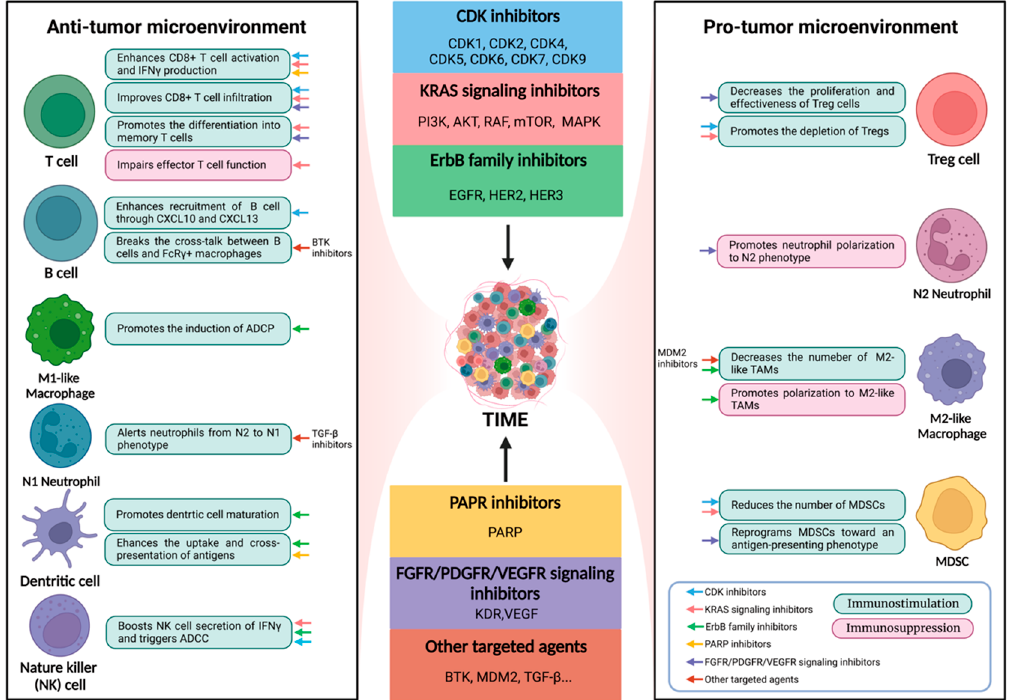
Figure 1. Modulatory Effects of Targeted Therapy on Immune Cells. The molecularly targeted agents function as immunostimulatory (the green block diagram) or immunosuppressive (the red block diagram) modulators in TIME. The color of each little arrow matches the corresponding drug category in the middle of figure. ADCC, antibody-dependent cell cytotoxicity; ADCP, antibody- dependent cellular phagocytosis; AKT, V-akt murine thymoma viral oncogene homolog; BTK, Bru- ton’s tyrosine kinase; CDK, cycle-dependent kinase; EGFR, epidermal growth factor receptor; FGFR, fibroblast growth factor receptor; HER, human epidermal growth factor receptor; KDR, kinase insert domain receptor; MAPK, mitogen-activated protein kinases; MDM2, mouse double minute 2; MDSC, myeloid-derived suppressor cell; mTOR, mechanistic target of rapamycin; PARP, poly(ADP-ribose) polymerase; PDGFR, platelet-derived growth factors receptor; PI3K, phosphatidylinositol-3-kinase; TAM, tumor-associated macrophage; TIME, tumor immune microenviron- ment; TGF- β , transforming growth factor- β ; Treg, regulatory T cell; VEGFR, vascular endothelial growth factor receptor (created with BioRender.com (accessed on 11 August 2022)).